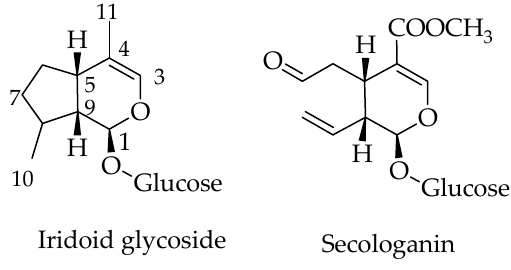
Figure 1. General structure of iridoids and secoiridoids.